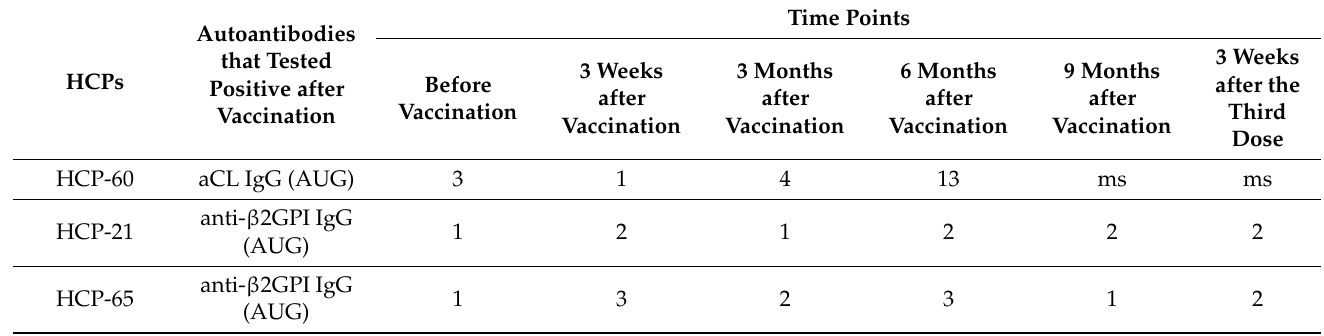
Table 4. Longitudinal data from HCPs who developed aPL during the observation period